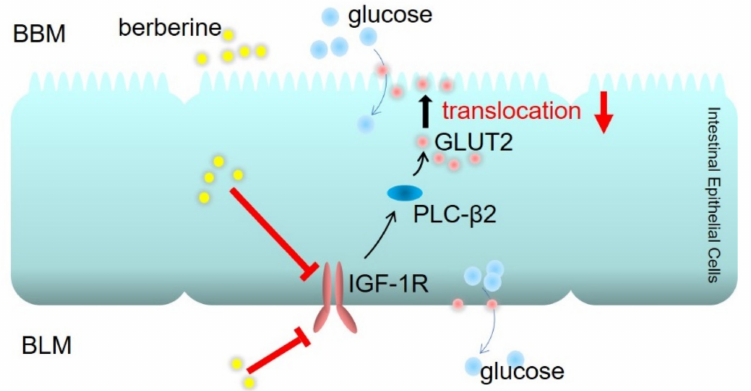
Figure 7. Schematic graph that illustrates the mechanisms of berberine for depressing intestinal glucose absorption and decreasing postprandial hyperglycemia. Through the inhibition of the IGF-1R-PLC- β 2-GLUT2 signal pathway, berberine decreases intestinal glucose absorption and im- proves postprandial hyperglycemia in diabetic